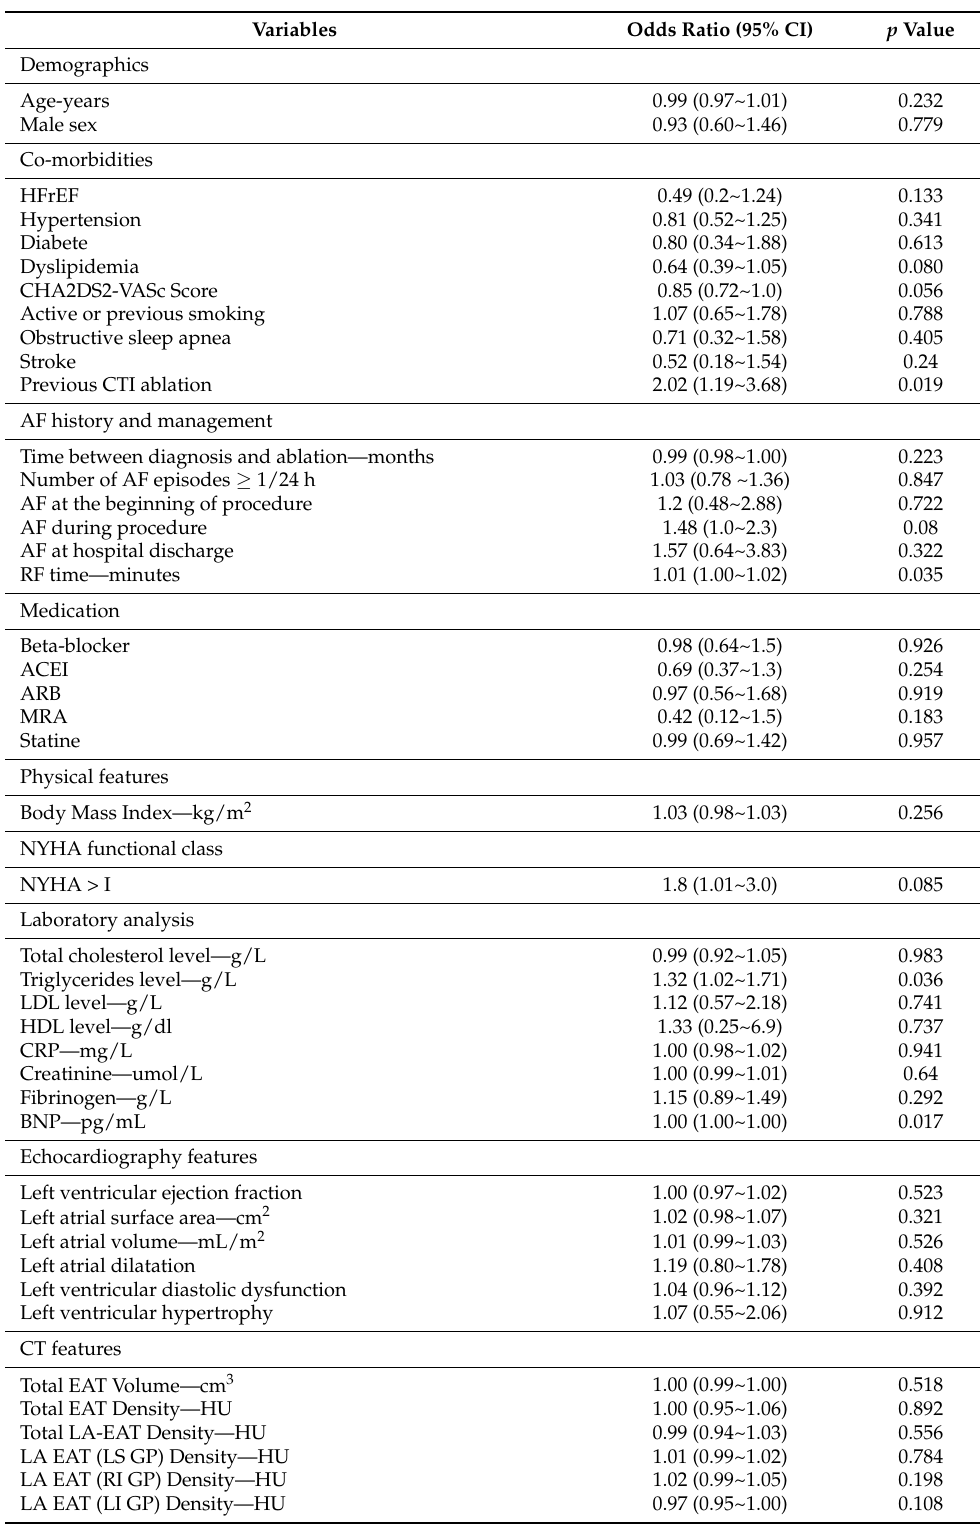
Table 2. Univariate analysis of AF recurrence after CA after 12-months